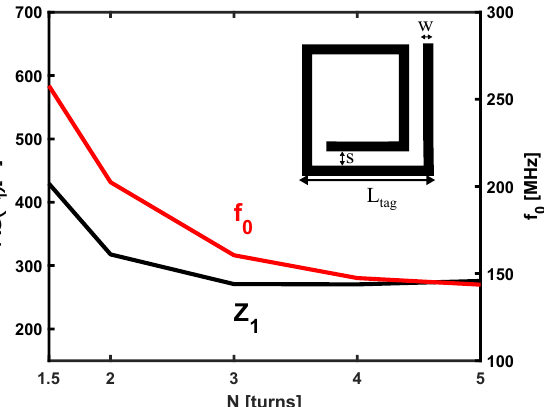
Figure 6. Effect of the number of turns N on the input impedance at the probe terminals and the resonant frequency of the SR. Results are plotted for L p = L tag = 50 mm, w = s = 2 mm, and d z = 20